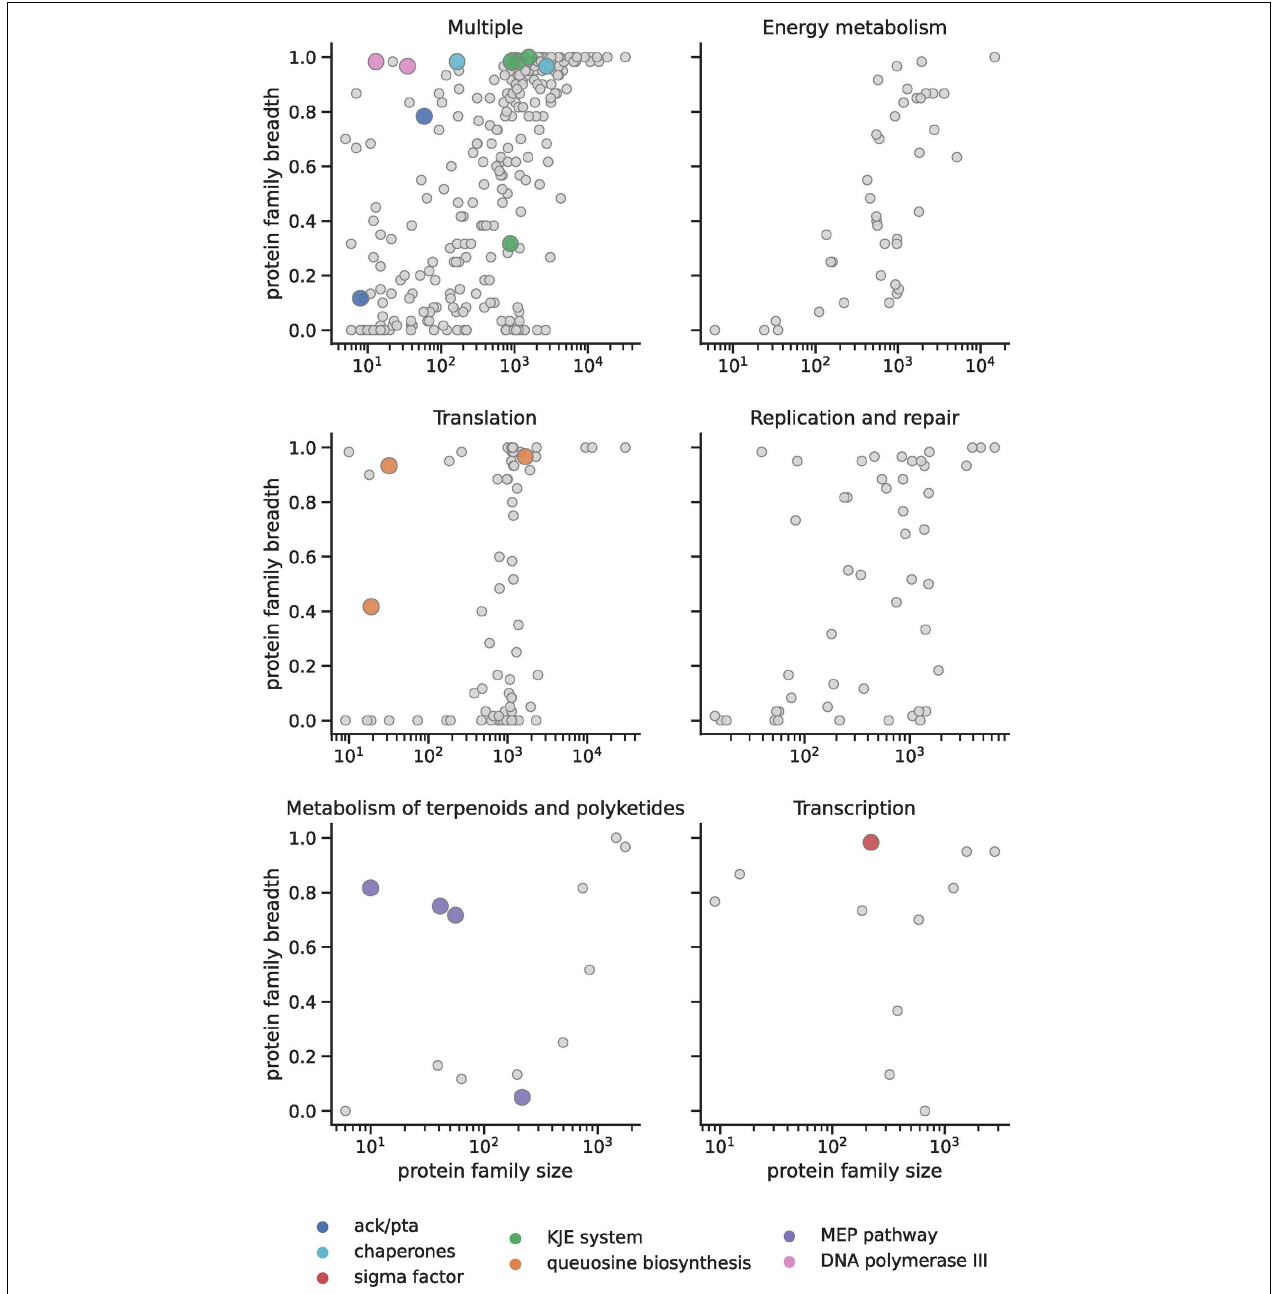
FIGURE 3 | Bacterial protein families found in DPANN genomes. In the top left plot, “multiple” refers to protein families that are found in more than one metabolic pathway. Colored dots indicate those instances in DPANN. For example, translation genes in the DPANN (pink dots) are genes involved in queosine biosynthesis (see